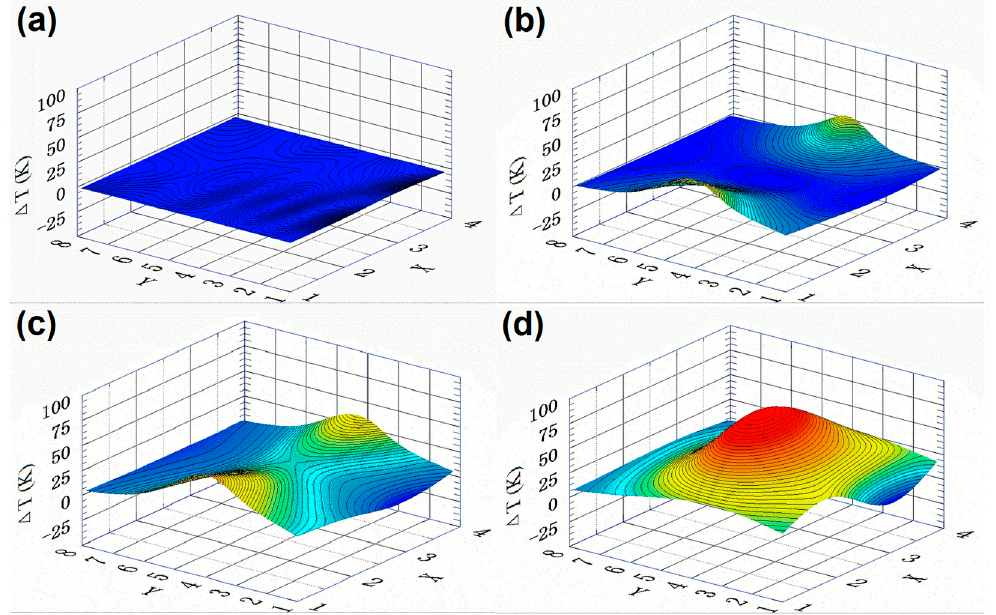
Figure 2. Measurement results taken from a continuous real-time mapping of a sample. ( a ) The resting state; ( b ) 20 s after two heaters are fixed at the two opposite edges at the same time; ( c ) After 50 s, these two edges increase in temperature; ( d ) After moving the two heaters both to the center of the sensing region and heating for 2 min, the central heating zone saturates in its temperature distribution.